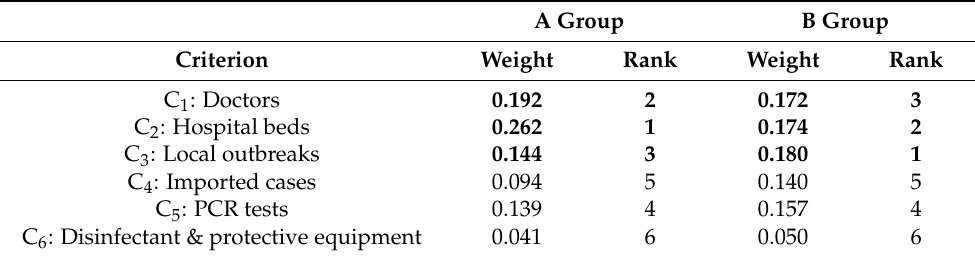
Table 4. Aggregated priority weights and criteria ranking for each participant group.